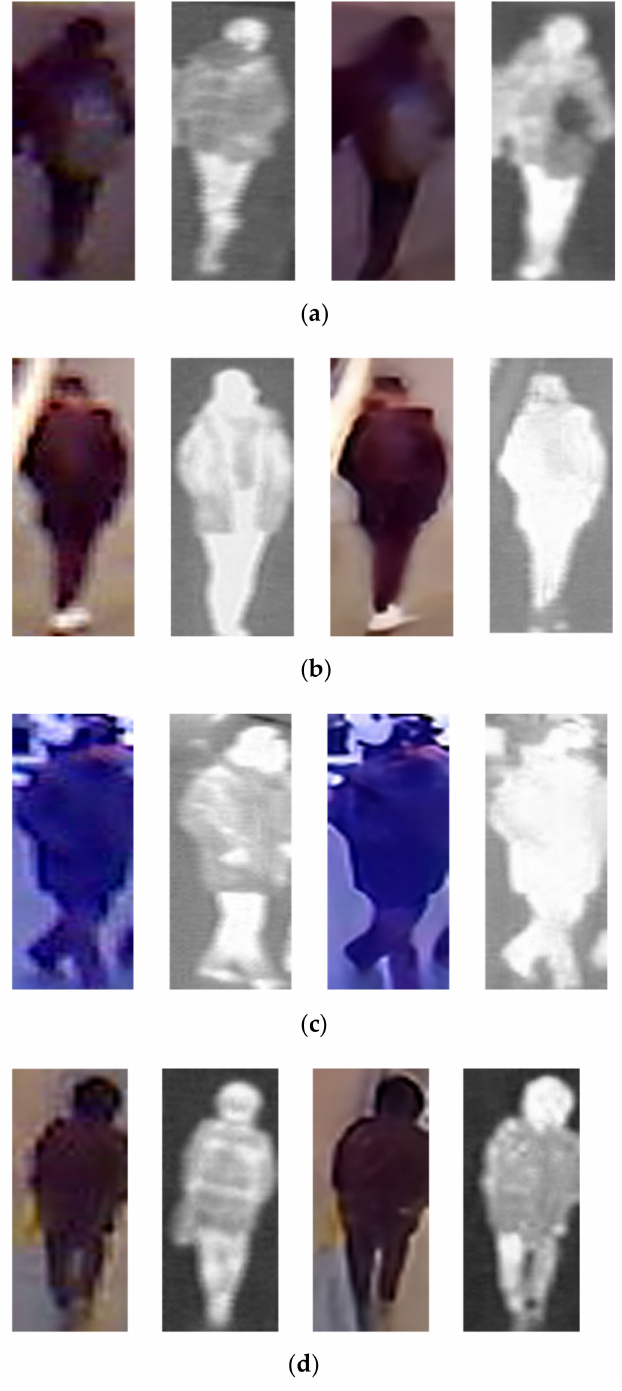
Figure 15. Cases of Type I error, Type II error, correct recognition. ( a ) Cases of Type I error, ( b ) cases of Type II error, ( c ) correct recognition cases (male), ( d ) correct recognition cases (female). In ( a – d ), from left to right are original visible-light image, original IR image, reconstructed visible-light image, and syn-IR